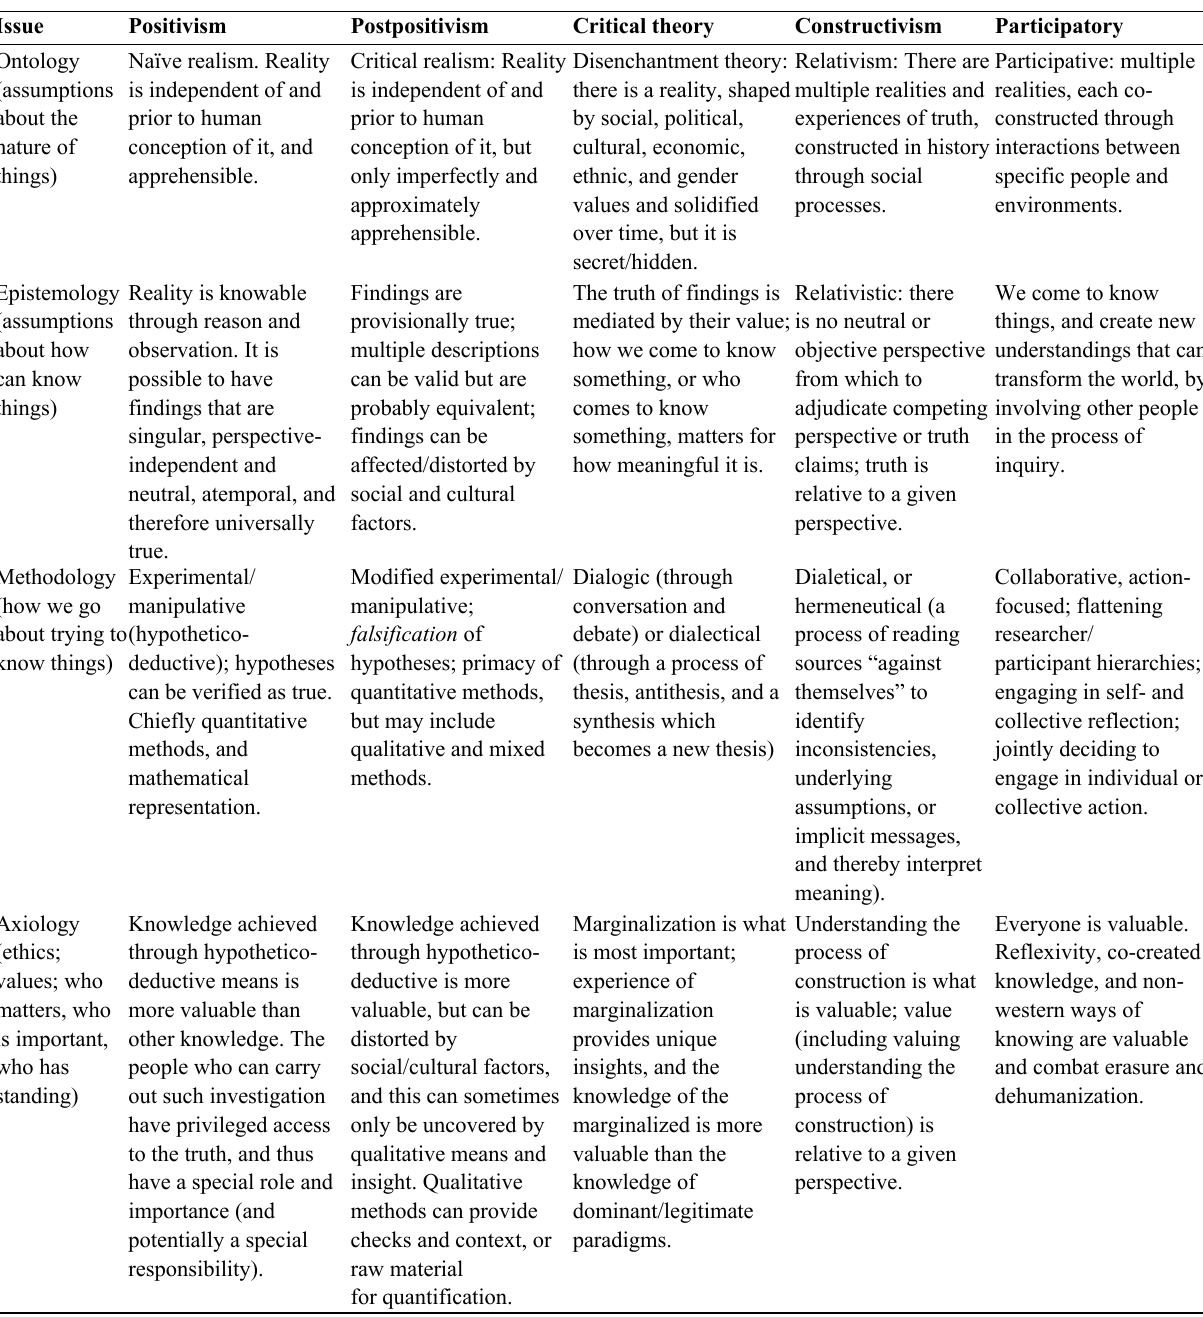
Table 1 Assumptions of social research paradigms. Based on Guba and Lincoln’s “Basic beliefs (metaphysics) of alternative inquiry paradigms” [7] . See Appendix for